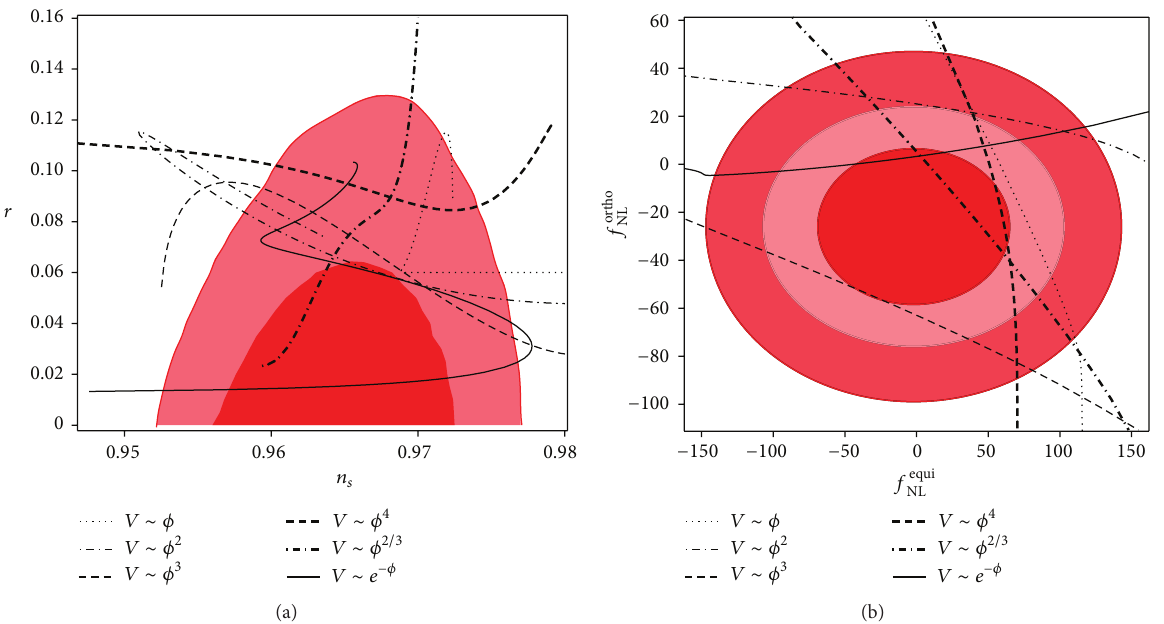
Figure 8: Tensor-to-scalar ratio versus the scalar spectral index for an inflationary model in which both inflaton and its derivative are nonminimally coupled to the gravity, in the background of Planck 2015 TT, TE, and EE + lowP data (a) and the amplitude of the orthogonal configuration of non-Gaussianity versus the amplitude of the equilateral configuration for an inflationary model in which both inflaton and its derivative are nonminimally coupled to the gravity, in the background of Planck 2015 TTT, EEE, TTE, and EET data (b). Figure is plotted with 𝑛 = 4 , 𝑓(𝜙) ∼ 𝜉𝜙 4 , and various types of potential, for 𝑁 = 60